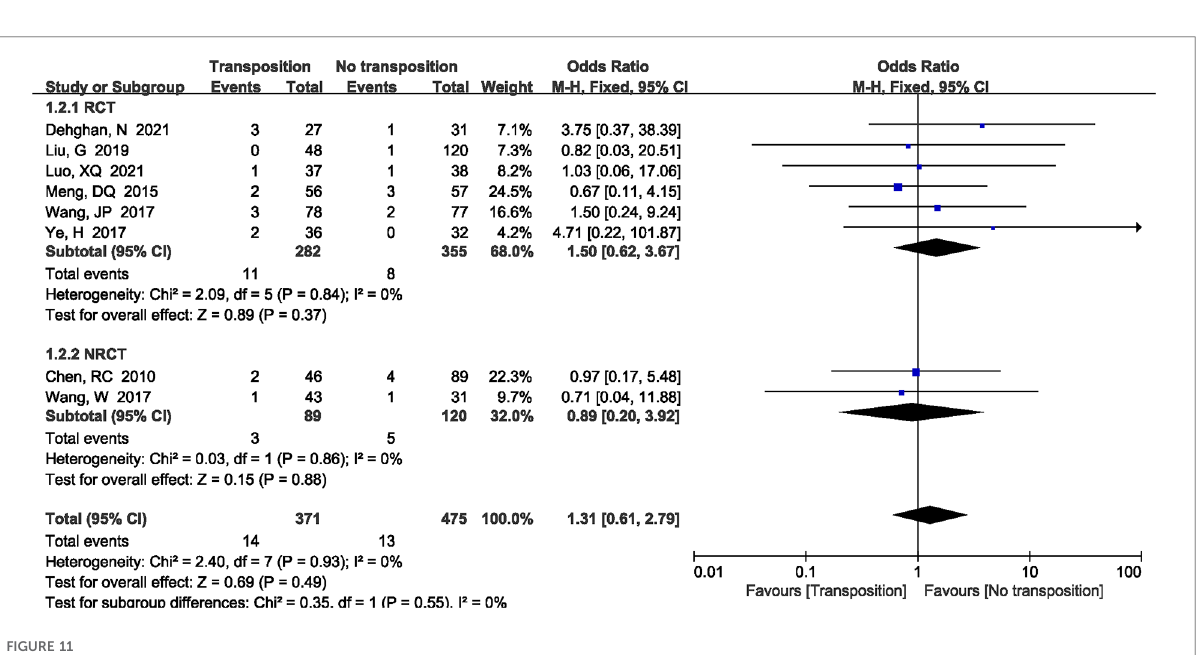
FIGURE 11 A forest plot showing the